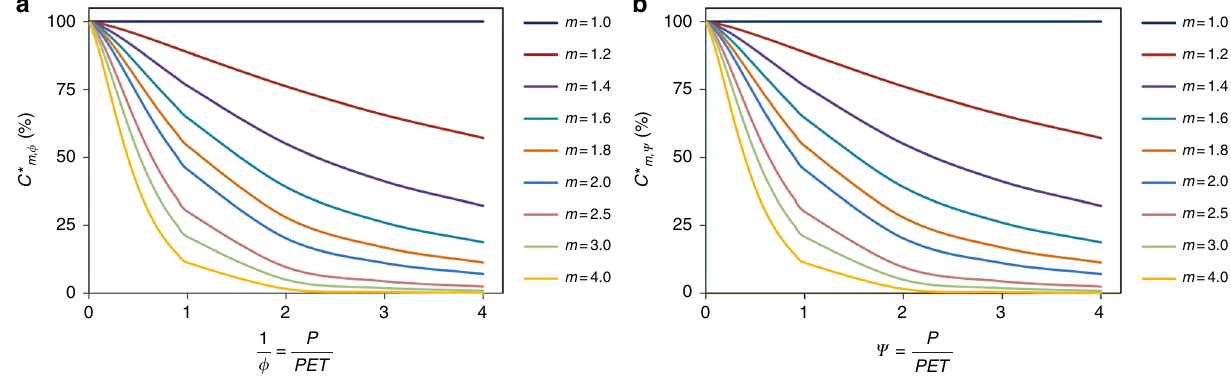
Fig. 2 The relative contribution of m to changes of R / P with regard to PET/ P . a C * m ϕ is computed using the dryness index given by Eq. (4) and b C * m, ψ is computed using the wetness index given by Eq.